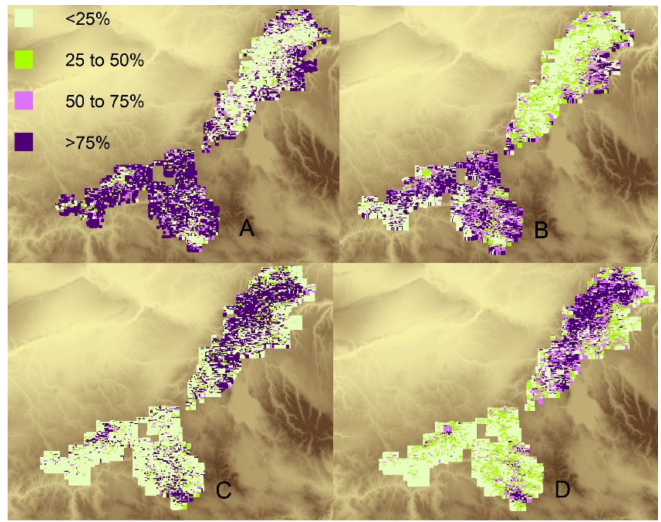
Figure 3. Predicted probabilities of pine presence by random forests ( A ) and extreme gradient boosting ( B ) and fir presence by random forests ( C ) and extreme gradient boosting ( D